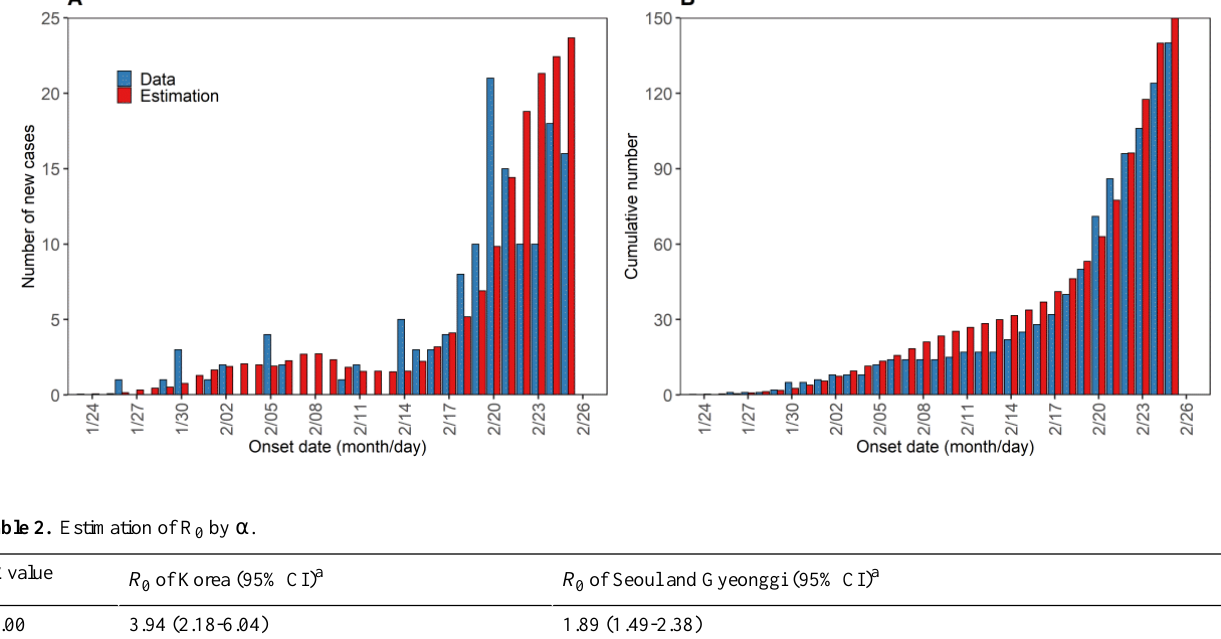
Figure 5. Comparison between estimated cases and observed cases of COVID-19 in Seoul and Gyeonggi using R 0 when α =0.07. (A) Daily local cases in Seoul and Gyeonggi. (B) Cumulative local cases in Seoul and Gyeonggi. The red bar shows the estimated cases, while the blue bar shows the observed COVID-19 cases in the Seoul and Gyeonggi regions.